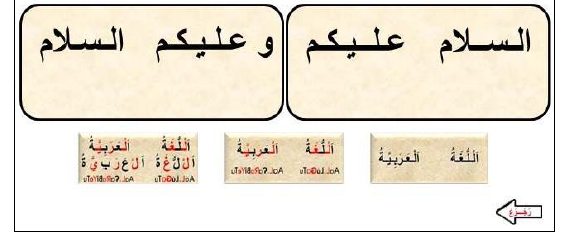
Figure 15. E-Learning system: Identification and reading/pronouncing